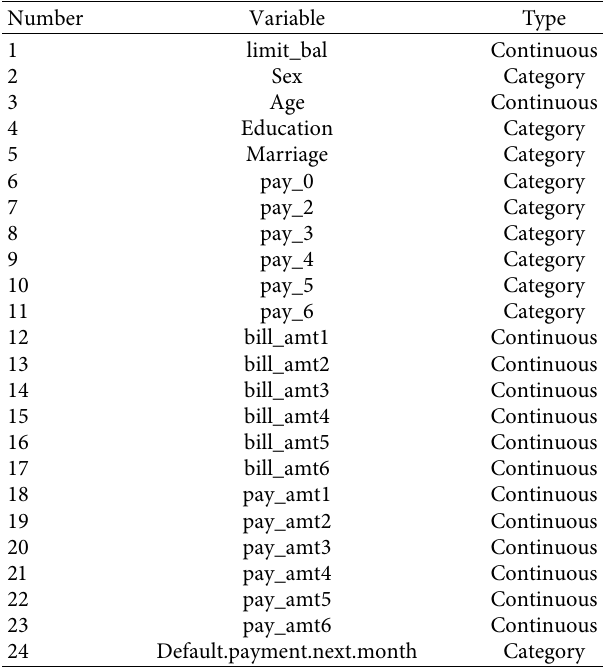
Table 1: Variable